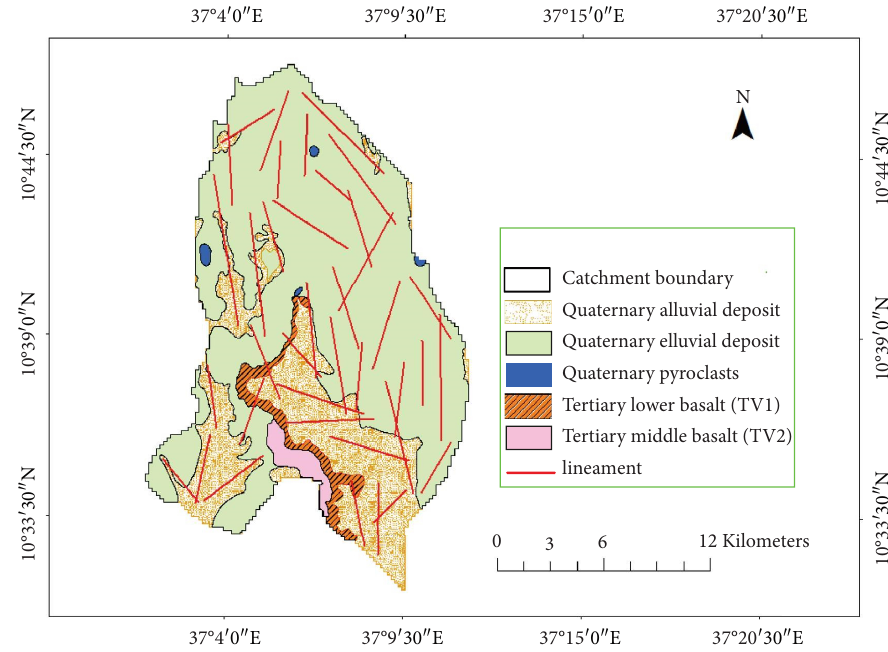
Figure 3: Geological map of the study